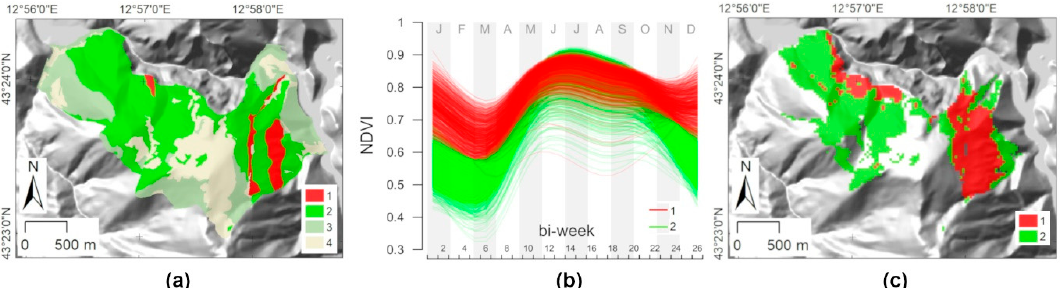
Figure 3. Phenoclusters of Mount Valmontagnana area identified by functional data clustering of pixel-based Landsat 8 NDVI time series. Clusters 1–4: 1, holm oak forest; 2, black hornbeam forest; 3, other forests; 4, other vegetation typologies (e.g., grassland). ( a ) Phytosociological map of Mount Valmontagnana area as in Frontoni et al. [40]; ( b ) mean annual phenological behavior (2013–2019) of two phenoclusters; ( c ) phenocluster map used to drive phytosociological sampling.